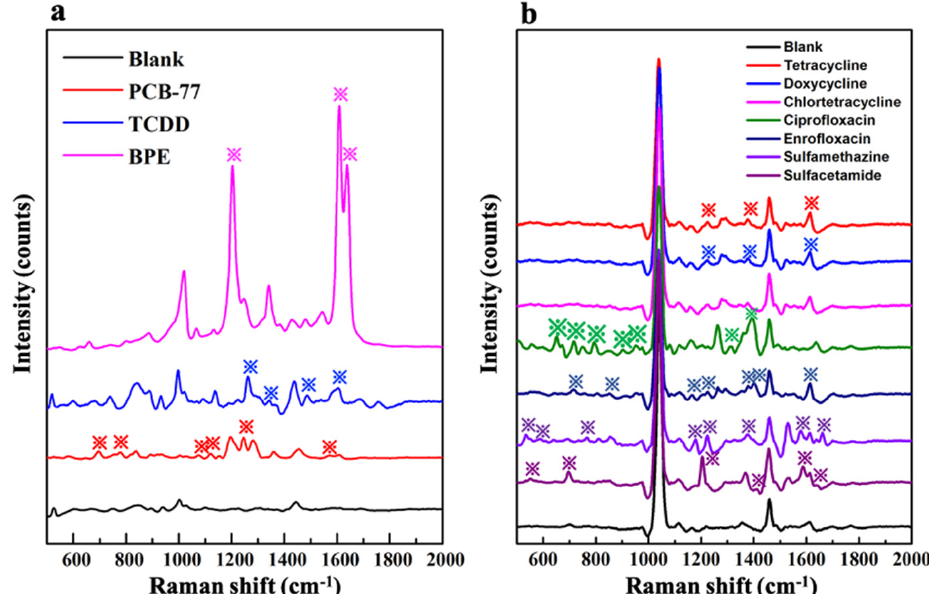
Figure 7. ( a ) SERS spectrum of the representative dioxin (2,3,7,8 − TCDD and PCB − 77) and BPE com ‐ pound; ( b ) SERS spectrum of seven kinds of the familiar antibiotic residue (tetracycline, doxycycline, chlortetracycline, ciprofloxacin, enrofloxacin, sulfamethazine, and sulfacetamide) in the presence of the optimized core-shell Au@BUT-17 substrates. The characteristic Raman peaks were labeled with asterisk.